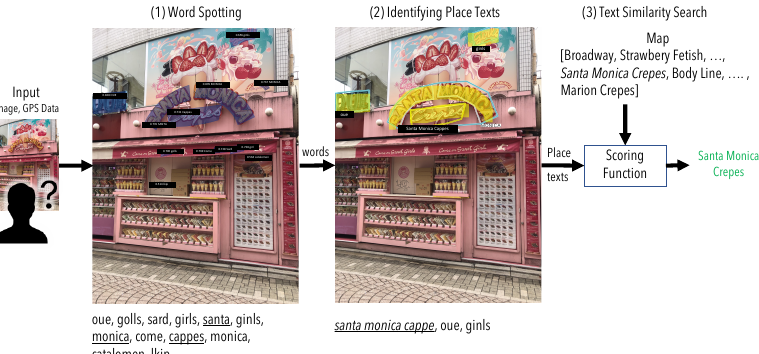
Figure 2. An example of place recognition through text reading: (1) detection and recognition of all word instances (oue, golls, sard, girls, santa, ginls, monica, come, cappes, monica, catalomen, lkip); (2) performing layout analysis (i.e., words into lines/regions) and filtering irrelevant texts (e.g., menus, banners) to identify the full place display texts (santa monica cappe, oue, ginls); (3) matching display texts against the listed place names to obtain the top